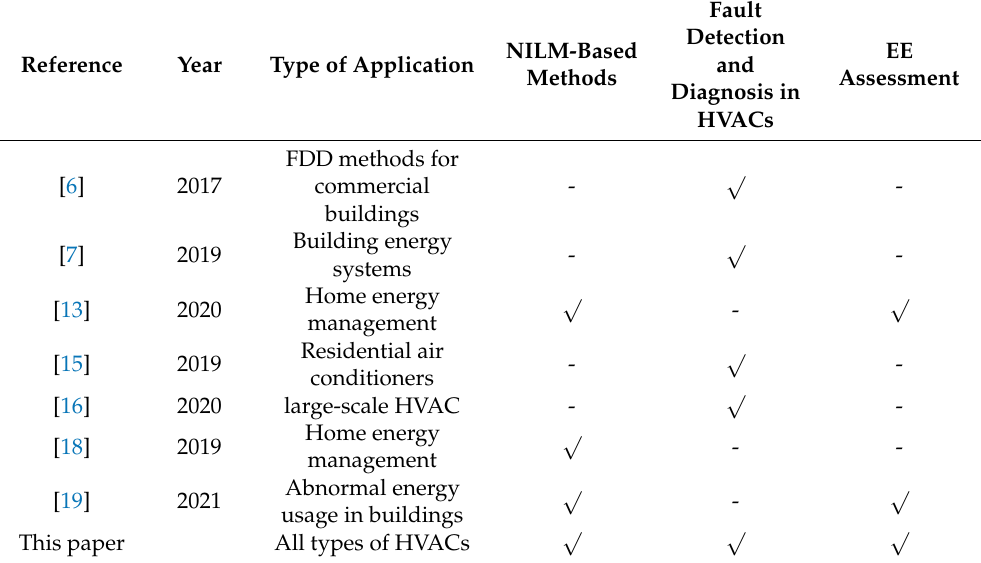
Table 1. Comparison of this study with other recent review papers in the context of FDD and Energy Efficiency assessment techniques in building